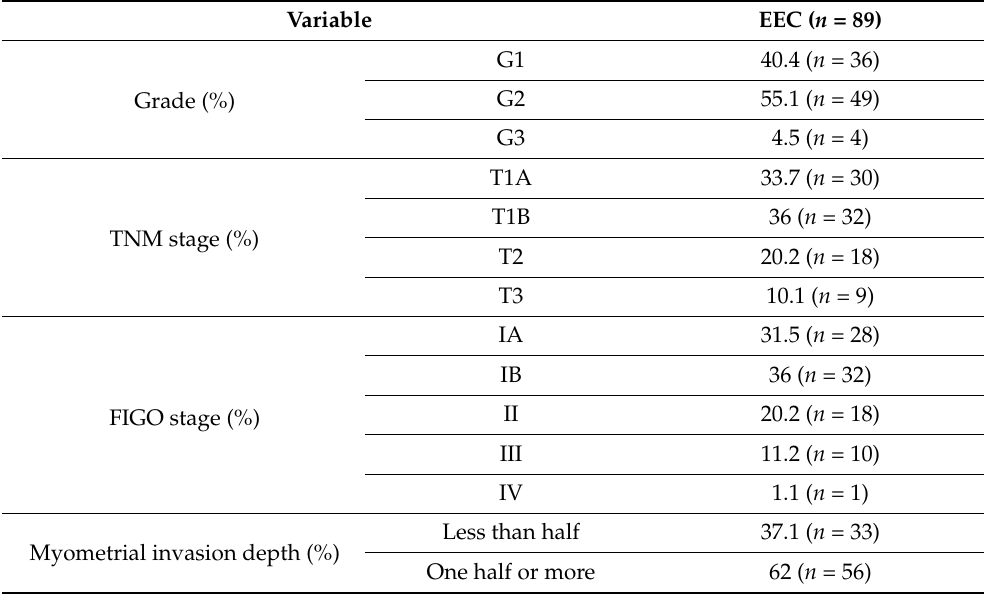
Table 1. Clinical and histological data of cancer